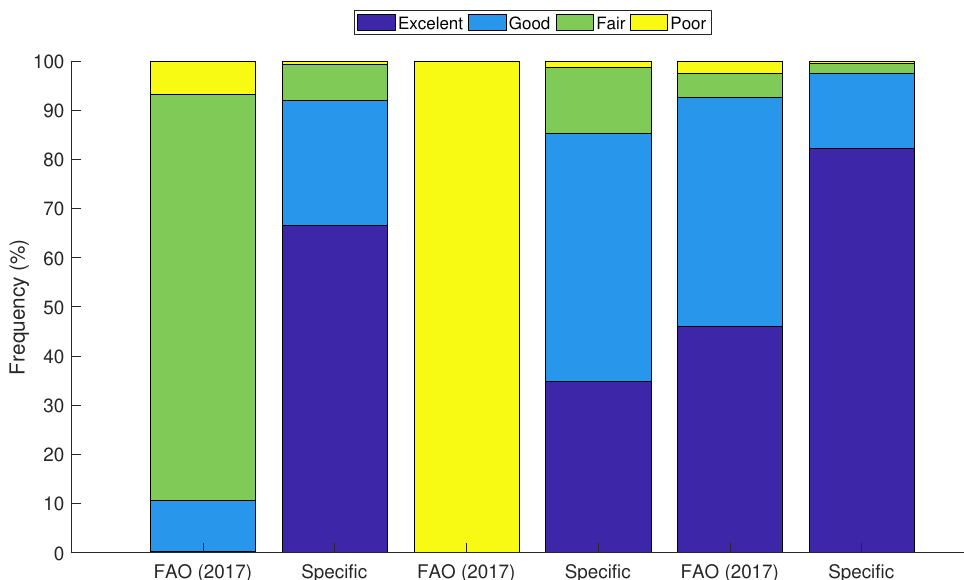
Figure 10. Comparison of the frequency of NRMSE values obtained by the proposed methodology and recommended by CROPWAT database